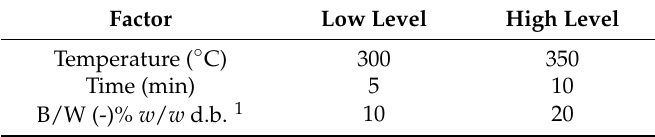
Table 1. Operating parameters of the design of the experiments